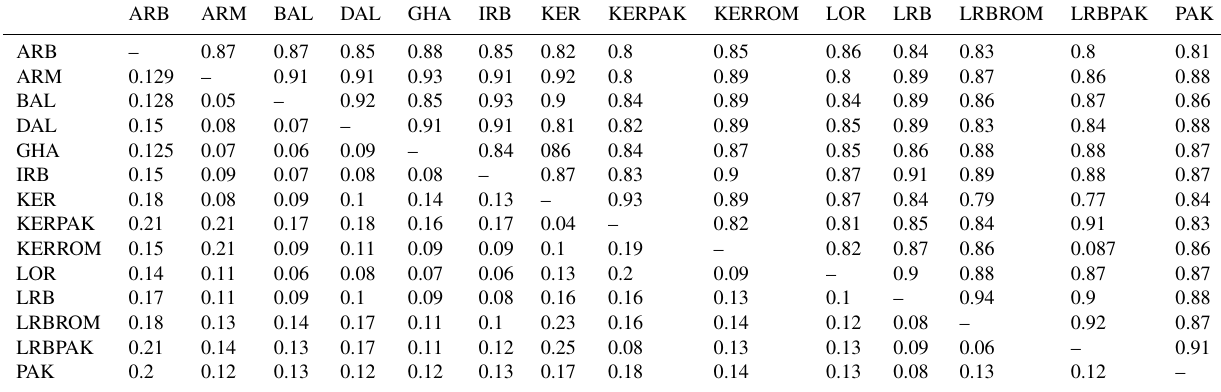
Table 6. Genetic distance matrices based on D A (upper diagonal matrix) and D AL (lower diagonal matrix) using 1000 bootstrap replications. ARB ARM ARB